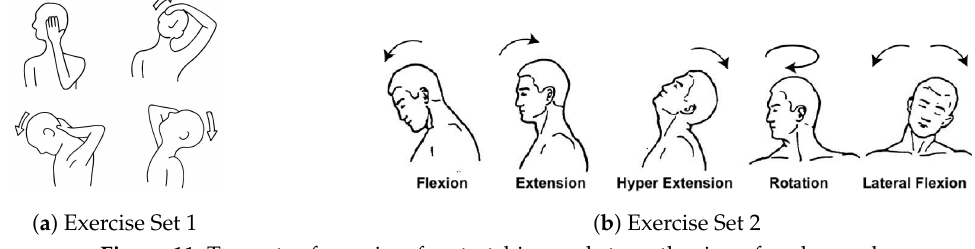
Figure 11. Two sets of exercises for stretching and strengthening of neck